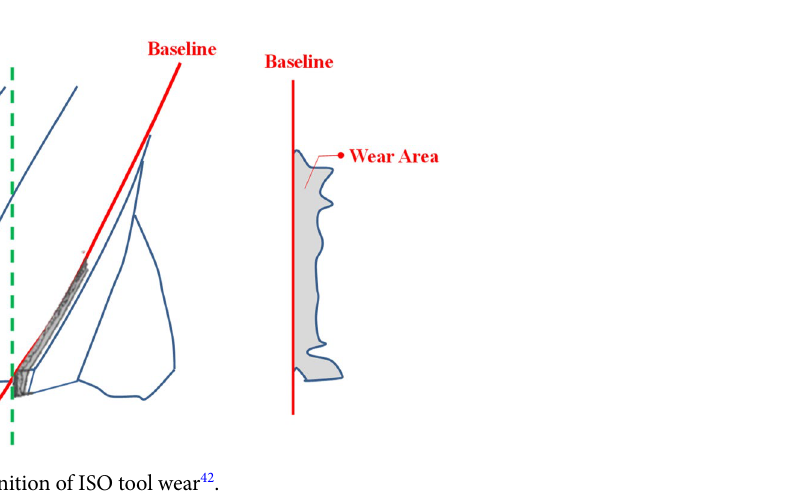
Figure 7. Definition of ISO tool wear 42